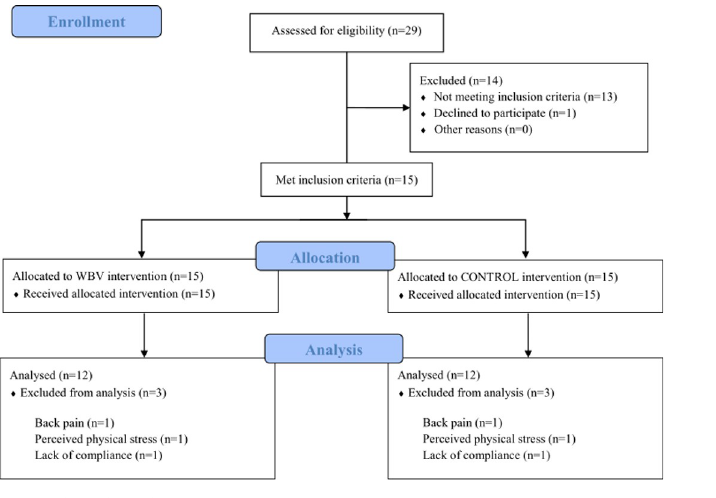
Fig 1. Flow chart